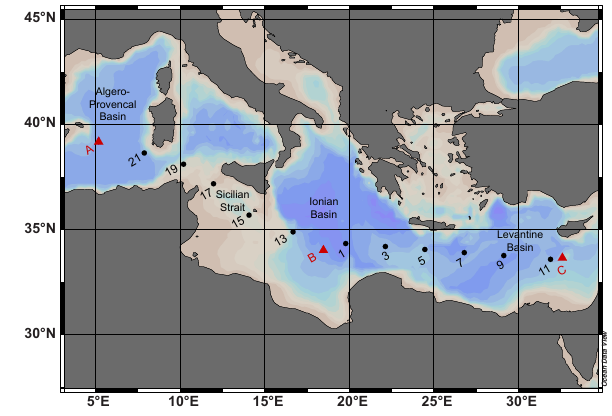
Fig. 1. Map of the Mediterranean Sea, colored to indicate bathymetry, with locations of sampling on the BOUM cruise. Num- bered stations (black circles) denote locations where a single depth profile was sampled; lettered stations (red triangles) denote loca- tions where multiple profiles were sampled in near proximity, and where microcosm incubations were